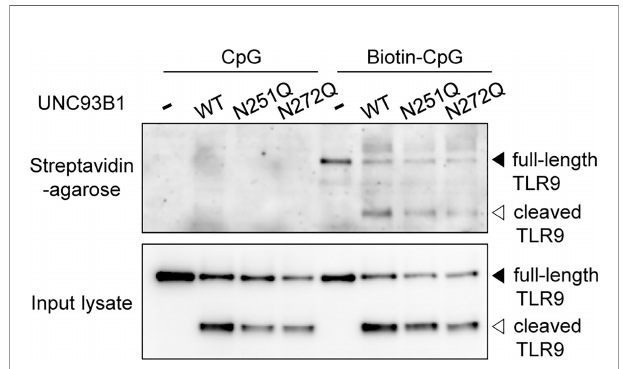
FIGURE 6 | Defective N-glycosylation of UNC93B1 does not alter binding of TLR9 to CpG DNA. UNC93B1-GFP (wild type or mutant) and TLR9-myc were expressed in UNC93B1 KO iBMDMs. After stimulation with 1 m M CpG DNA or biotin-CpG DNA for 4 h, cells were lysed and biotin-CpG DNA was isolated with streptavidin-agarose beads. TLR9-myc bound to biotin-CpG DNA (top panel) or in the input cell lysates (bottom panel) was detected by immunoblotting with anti-myc antibody.